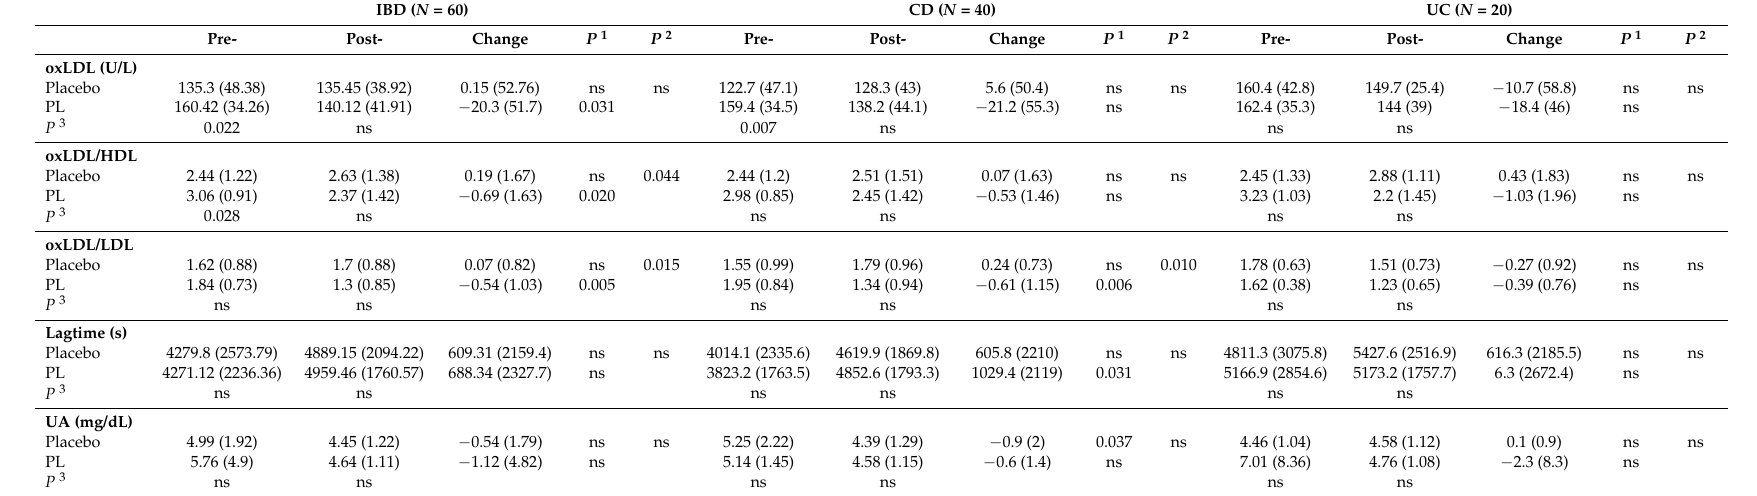
Table 3. The oxidative stress markers at baseline and at follow-up. Values are expressed as the mean ±